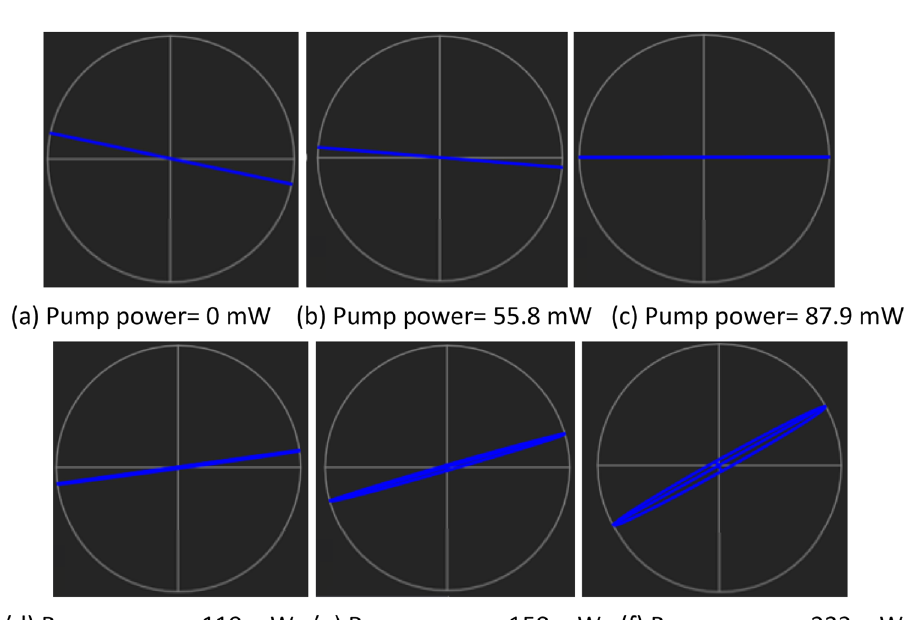
Figure 6. Evolution of light polarization state rotation at various pump powers in 2D view ( a ) 0 mW ( b ) 55.8 mW ( c ) 87.9 mW ( d ) 119 mW ( e ) 150 mW ( f ) 223